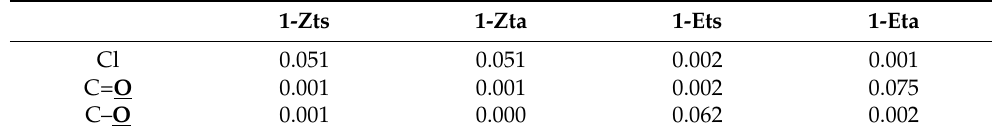
Table 6. Delocalization Indices for the non-covalent interactions of the N– H hydrogen atom with the chlorine and oxygen atoms of the 1 - Φ t γ isomers. One member of the atom pair is always the hydrogen atom bonded to nitrogen, N- H , while the other is reported in the first column. 1-Zts 1-Zta 1-Ets 1-Eta Cl 0.051 0.051 0.002 0.001 C= O 0.001 0.001 0.002 0.075 C– O 0.001 0.000 0.062